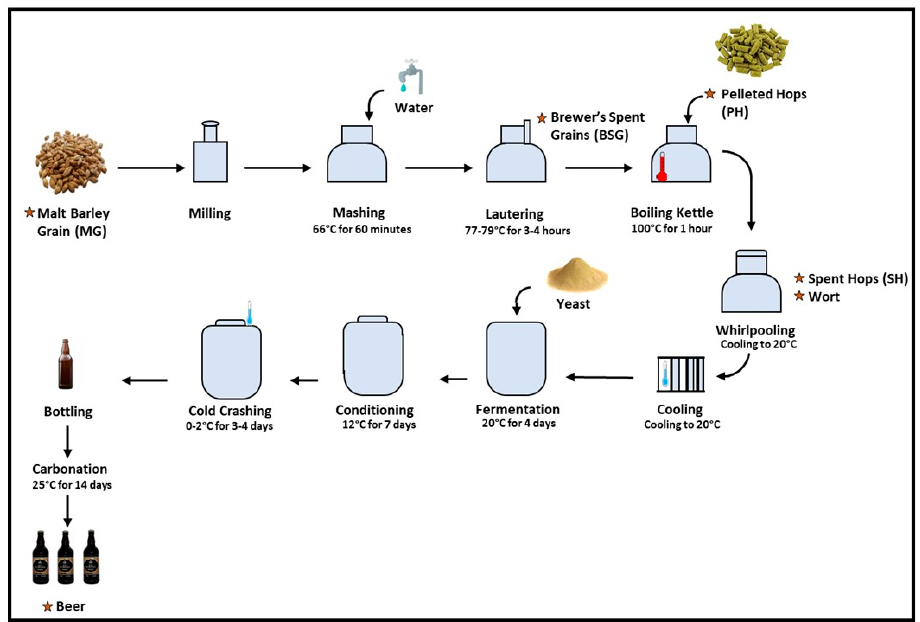
Figure 1. A schematic of the brewing process for the production of Irish red ale outlining the sampling points for the brewing materials, by-products, wort, and beer as highlighted with a star.